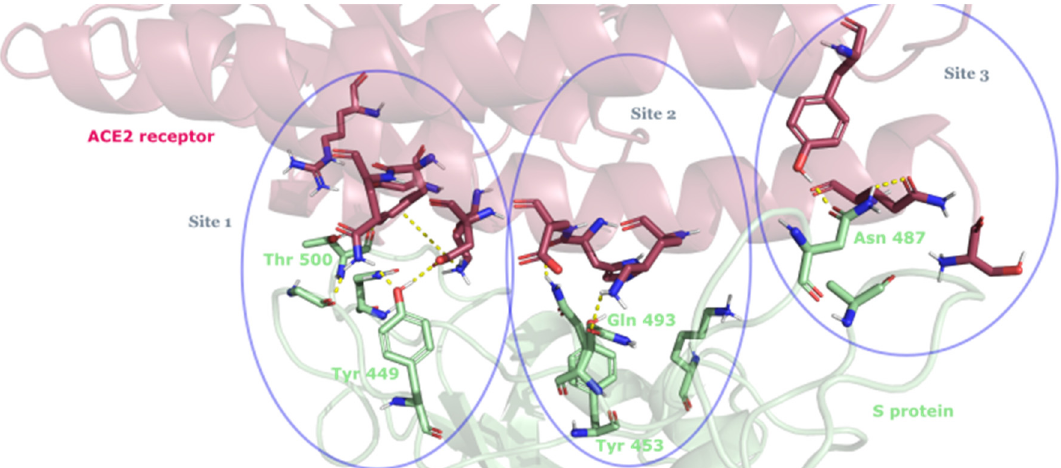
Figure 3. The interface between the viral S protein and ACE2 host cell receptor. Residues are colored according to the atom type of the interacting amino acid residues (the S protein’s carbon, pale green; the ACE2 receptor’s carbon, red; oxygen, red; nitrogen, blue). Dash lines represent the protein–ligand interactions: hydrogen bond interactions are colored in yellow. Figure adapted from Unni et al., 2020.